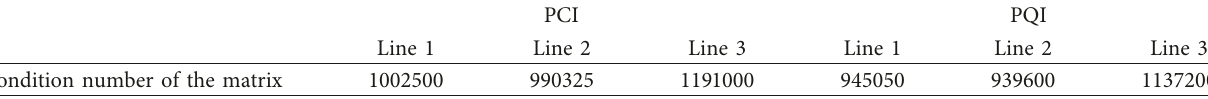
Table 2: Condition number of the GM (1, 1) model matrix obtained by directly using the values of PCI and PQI.